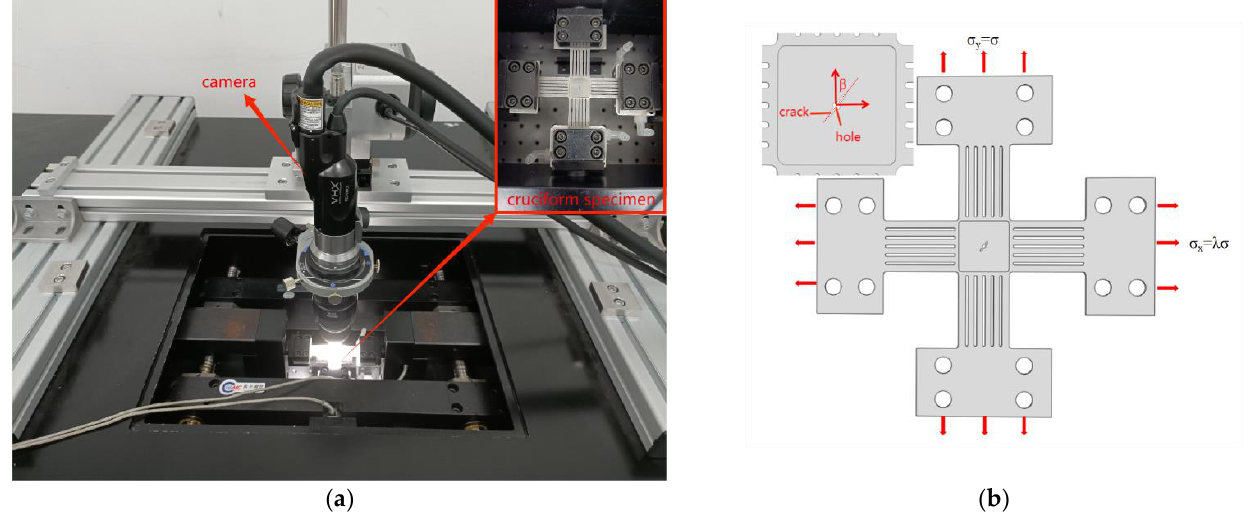
Figure 1. ( a ) Biaxial fatigue test machine. ( b ) The cruciform specimen (λ = 0, 0.5 and 1). Table 1. Test scheme of biaxial fatigue crack growth of cruciform specimen. β λ ( λ = σ x / σ y ) P max /N R ( R = P min / P max ) 0 90 ◦ /60 ◦ /45 ◦ 2000